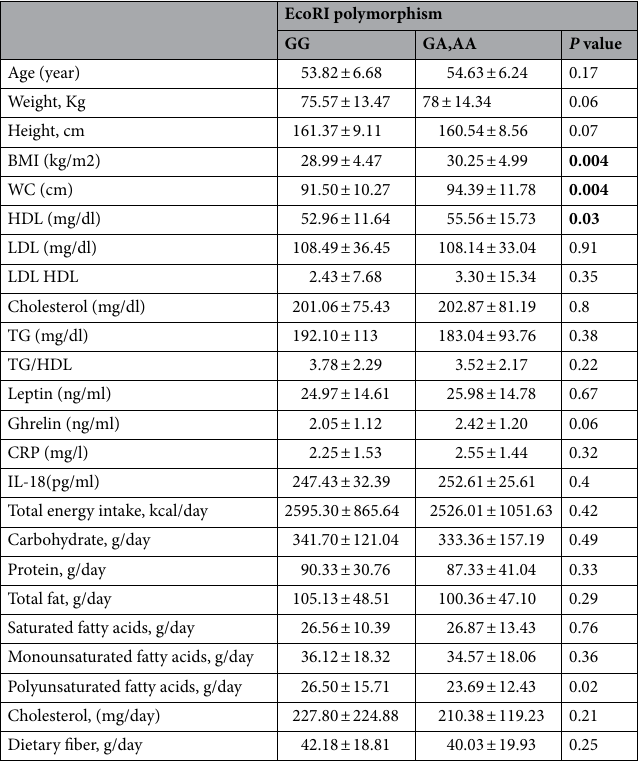
Table 2. General, anthropometrical and dietary intake characteristic according to EcoRI genotype. Data are presented as mean ± standard deviation (SD). BMI body mass index, HDL-c high density lipoprotein cholesterol, LDL-c low density lipoprotein cholesterol, TG triglyceride, CRP C-reactive protein, IL18 interleukin 18, PGF2α prostaglandinF2α a. P values obtained from Independent